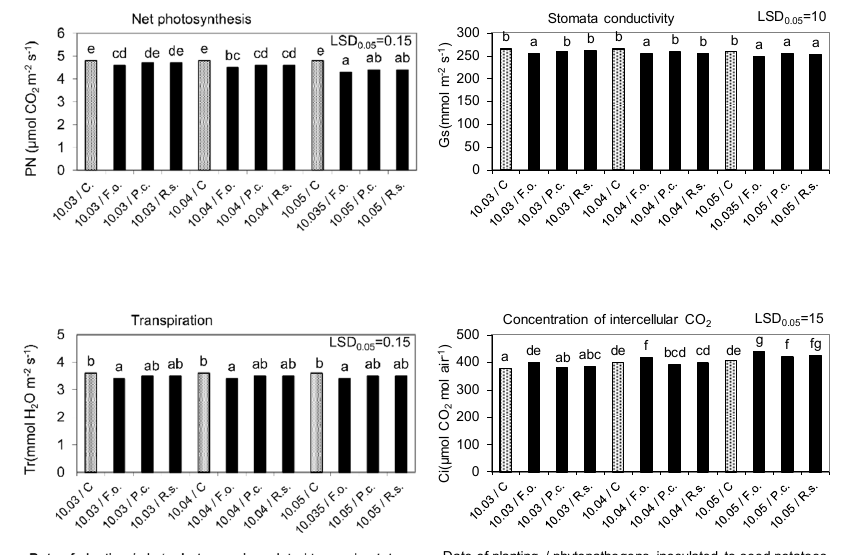
Figure 8. Gas exchange in potato leaves, as affected by seed potatoes storage at 4 ◦ C from harvest until inoculation with phytopathogens on 10 February and then at 15 ◦ C and 80% RH before planting in the soil on 10 March, 10 April, and 10 May. C—Control, Fo— F. oxysporum , Pc—P . corotovorum , Rs— R. solani . Means marked with the same letters do not differ statistically at the significance level p = 0.05. LSD was calculated at the significance level of p = 0.05.